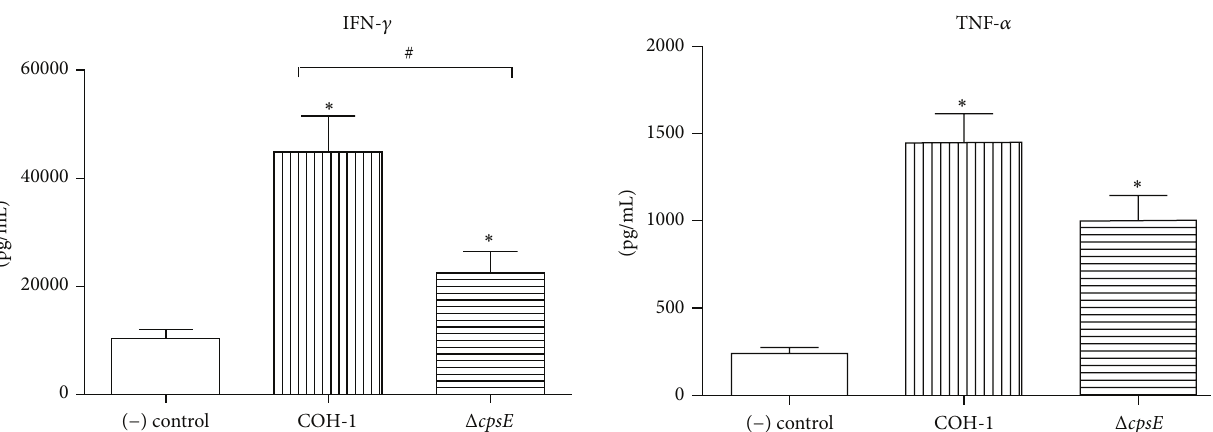
Figure 7: Role of bacterial capsular polysaccharide in the modulation of cytokine production by CD4 + T cells. Dendritic cells (DCs) were infected with either wild-type GBS strain COH-1 or its nonencapsulated isogenic mutant Δ cpsE (MOI:1) for 1h. Extracellular bacteria were killed by antibiotic treatment and cultures washed prior to addition of freshly isolated splenic CD4 + T cells from na¨ıve mice (T cell :DC ratio of 5 :1). Cocultures were incubated for 48 h, resuspended in fresh medium containing 10ng/mL of IL-2 for 72 h (resting period), and then transferred to anti-CD3 coated plates for 48 h. Supernatants were then collected and cytokines quantified by ELISA. Nonstimulated cocultures served as negative ( − ) controls for basal expression. Data are expressed as means ± SEM (in pg/mL) from 5 different experiments. ∗ 𝑃 < 0.05 indicates statistically significant differences compared to ( − ) control. # 𝑃 < 0.05 indicates statistically significant differences between cocultures infected with wild-type strain COH-1 and those infected with the nonencapsulated mutant Δ cpsE